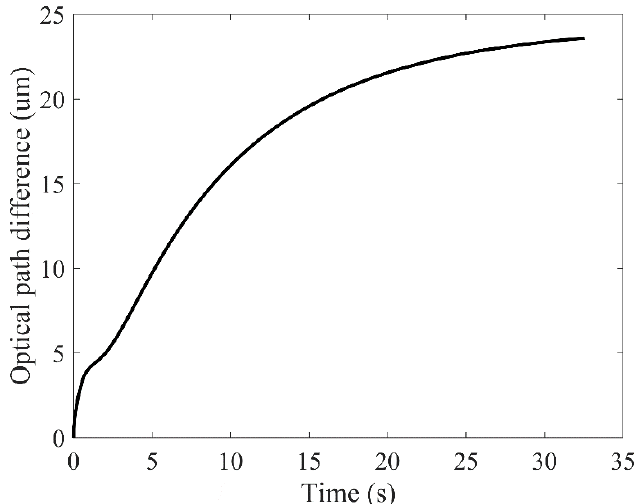
Figure 3. Interference light intensity variation with the relaxation time. t = 0 is the moment when the LC cell driving voltage V m = 5 V is turned off. ( a ) The 1053 nm DFB fiber laser; ( b ) the halogen light.